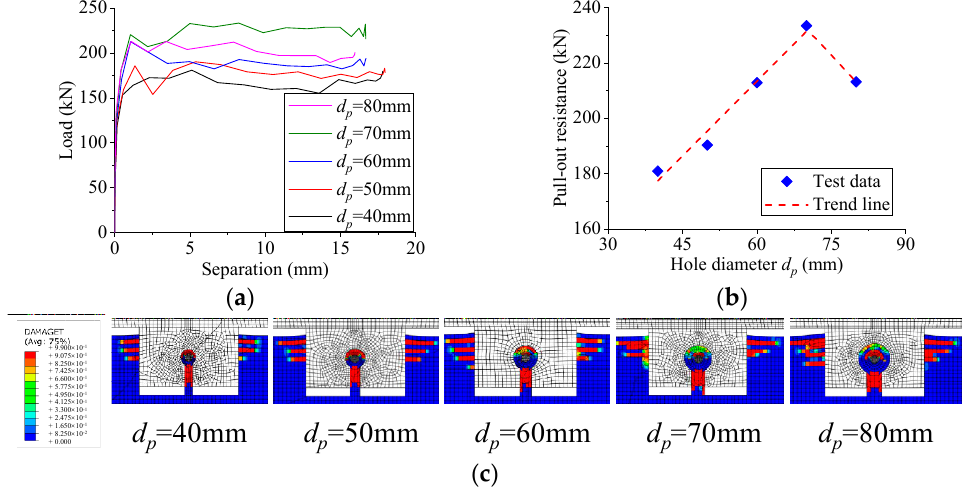
Figure 14. Influence of hole diameter. ( a ) Load–separation curves; ( b ) influence analysis; ( c ) failure mode.